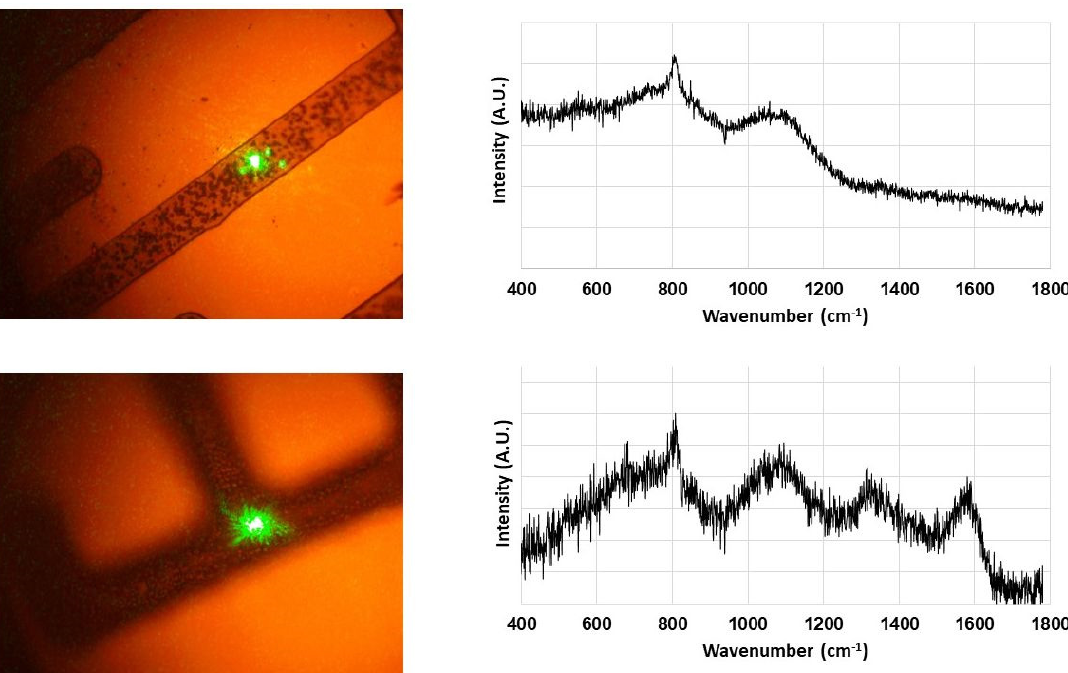
Figure 6. Raman spectra of B-C microstructures. The green dot on the microstructures is the 532 nm laser used for spectroscopy. Raman spectra show the presence of both amorphous (top row) and crystalline B 50 C 2 (bottom row) in these microstructures.